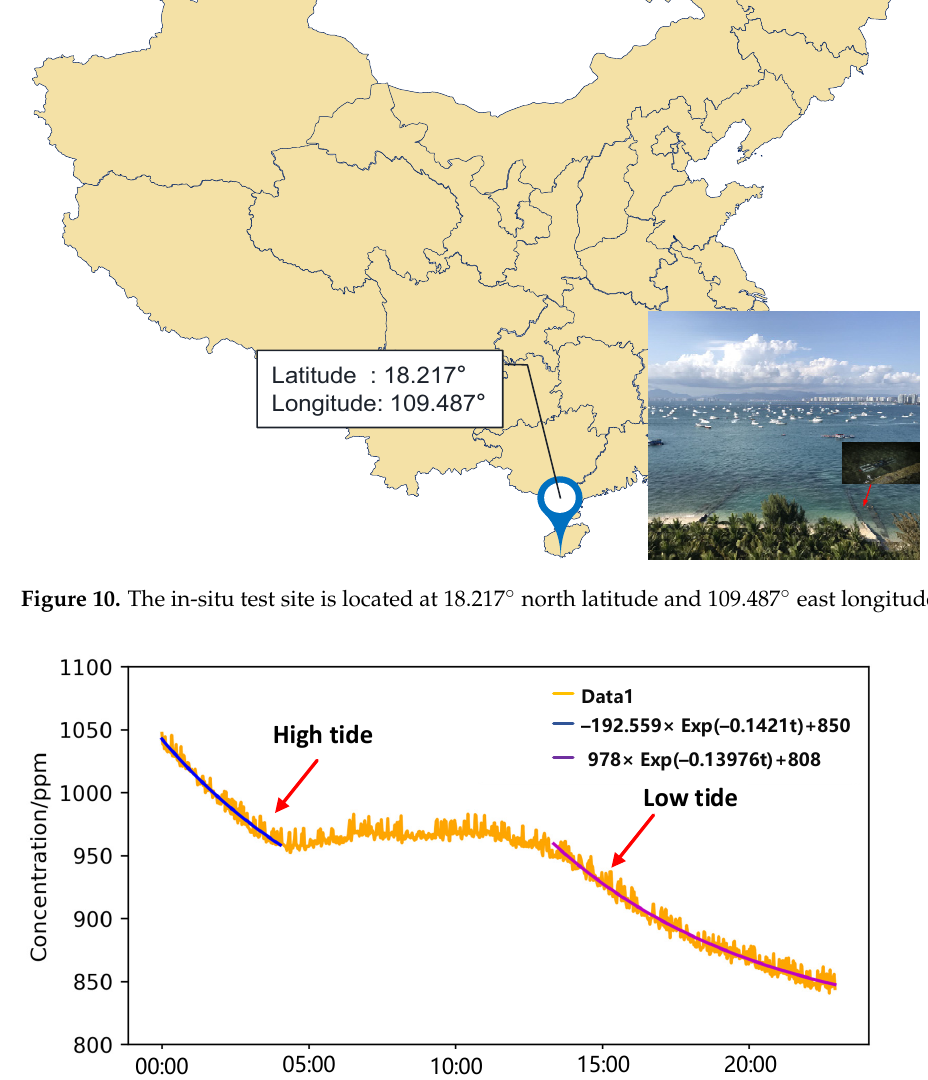
Figure 10. The in-situ test site is located at 18.217° north latitude and 109.487° east longitude.